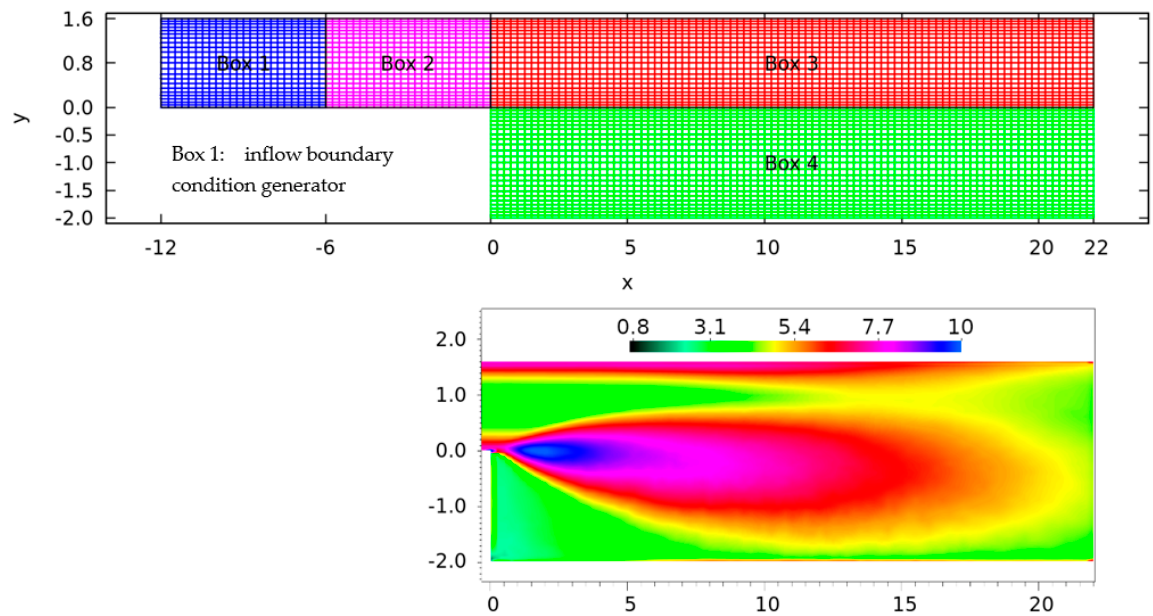
Figure 2. Top : DNS spectral element mesh. Bottom : reference mesh dimension divided by the local Kolmogorov scale in Figure 2. Top: DNS spectral element mesh. Bottom: reference mesh dimension divided by the local Kolmogorov scale in the z = 0 the z = 0 plane.